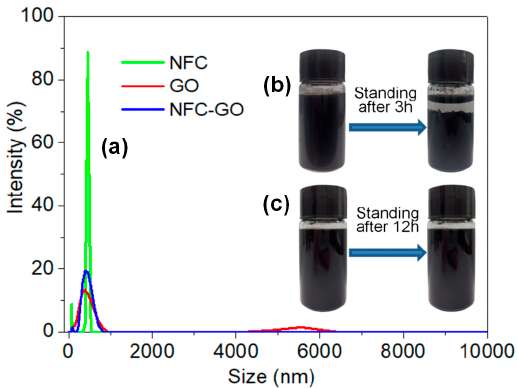
Figure 2. ( a ) Size distribution of the dispersions; ( b ) Standing stability of the graphene dispersion, concentration 0.25 mg·mL − 1 ; ( c ) Standing stability of mixed dispersion with 50 wt.% graphene, GO:NFC = 1:1, 0.25 mg·mL − 1 .